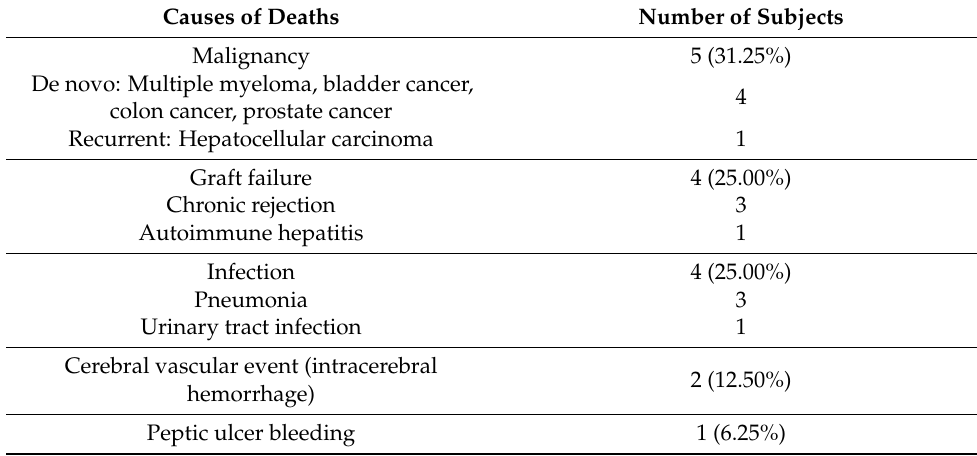
Table 2. The causes of 16 deaths since 5 years after adult liver